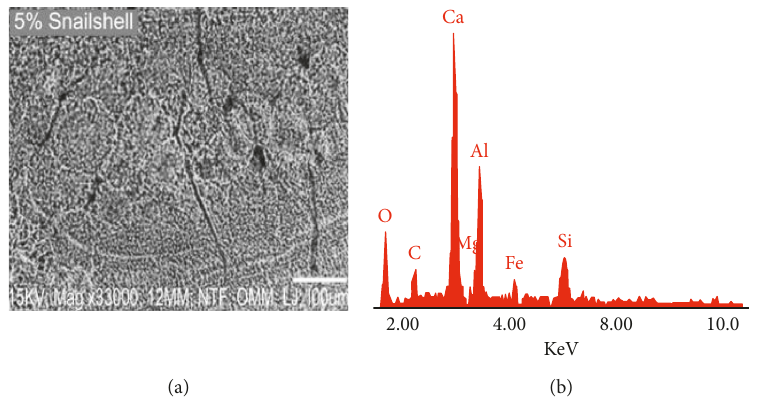
Figure 11: (a) SEM image of AA6061+5 wt% snail shells; (b) EDS of AA6061+5 wt%.